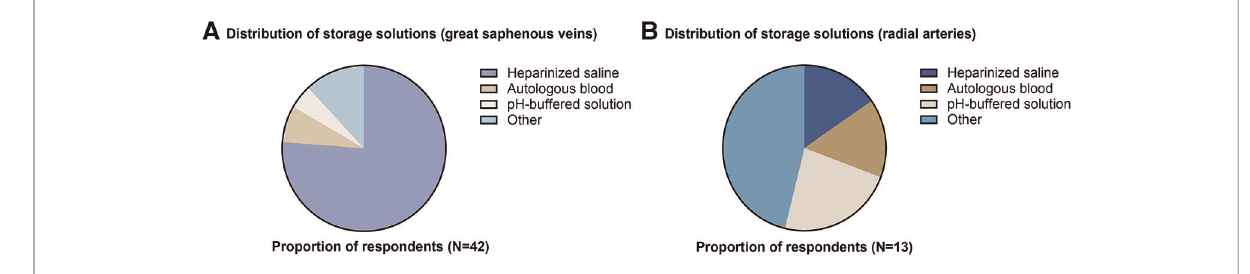
FIGURE 1 Distribution of storage solutions used for ( A ) great saphenous veins and ( B ) radial